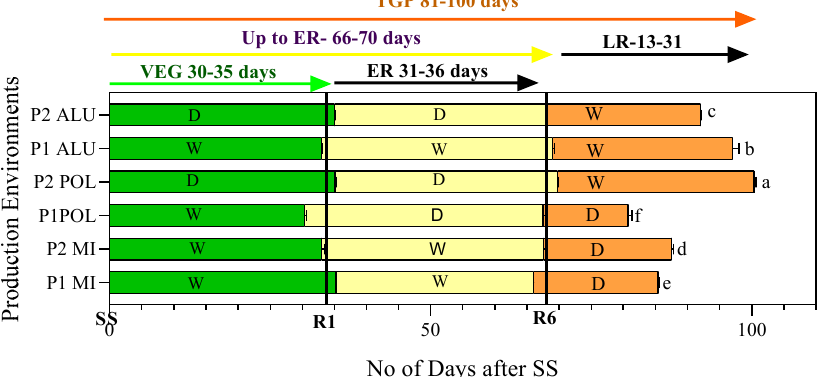
Figure 1. Number of days taken to complete different growing stages in soybean grown at different production environments. Growth phases were recorded according to Fehr and Caviness [25], whereby R1 indicates beginning of flowering, R6, full seed, and R8, fully matured seeds. Total growing period (TGP) means followed by the same letter (s) in the column do not differ significantly, LSD at p < 0.05. Note: VEG—vegetative; ER—early reproductive; LR—late reproductive. Different weather conditions were observed in each location during the cropping pe- riod, as in planting 1 (P1) (December 2018 to April 2019) and Planting 2 (P2) (June 2019– September 2019). The summary of meteorological data (maximum temperature, growing degree days (GDD), average relative humidity and cumulative rainfall) during vegetative, early reproductive, and late reproductive periods for the six production environments are presented in Table 1. Table 1. Maximum temperature (°C), growing degree days (GDD), average relative humidity (RH%) and cumulative rainfall (mm) during vegetative (SS–R1), early reproductive (R1–R6) and late reproductive (R6–R8) at six production environments. PE